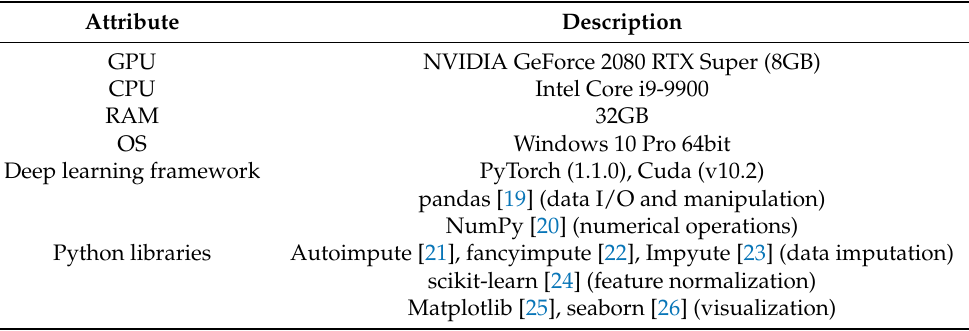
Table 2. Experimental